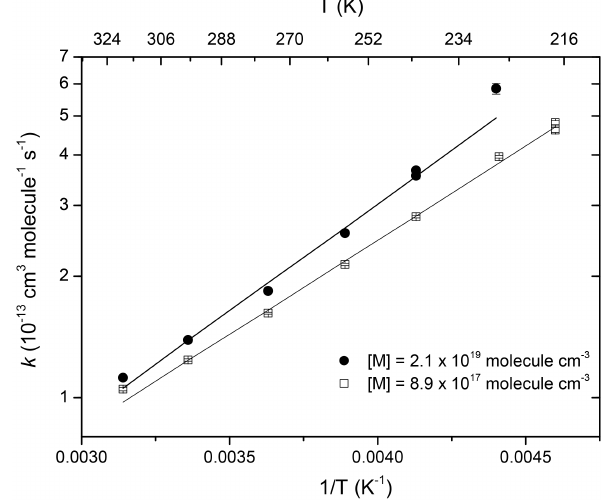
Figure 8. Temperature-dependent rate coefficients at two constant bath gas concentrations [ M ] . The statistical uncertainties of the ex- perimental data are within the symbol size. The solid lines are Ar- rhenius fits to the data (see